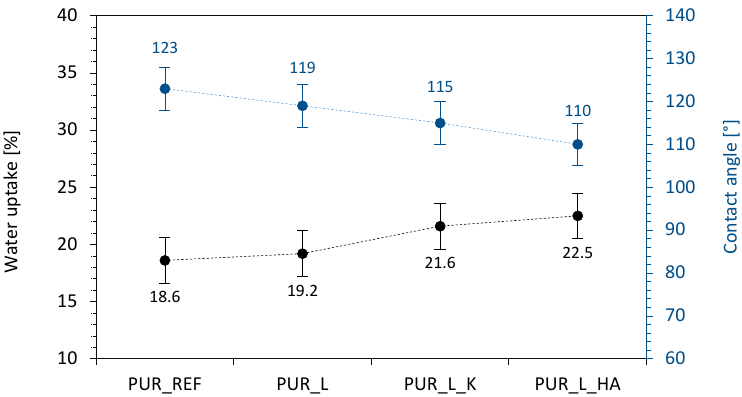
Figure 10. Selected properties of PUR composites—water uptake and contact angle results.